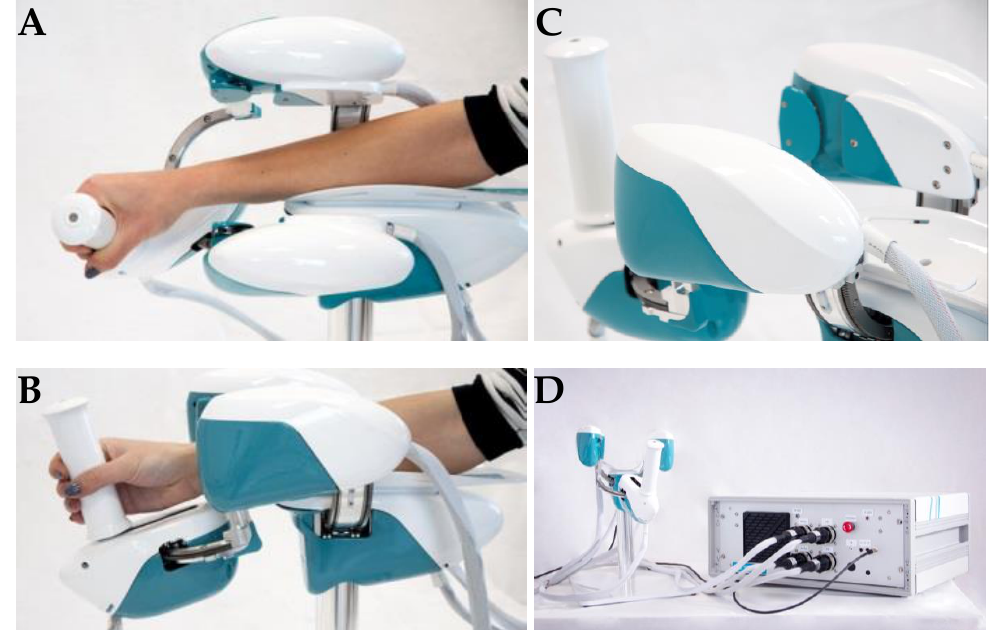
Figure 1. Lateral view of WristBot during combined movements in the flexion – extension and pronation – supination DOFs (degrees of freedom) ( A ) and movements in the radial – ulnar deviation DOF ( B ); posterior – lateral view of the handle of WristBot ( C ) and a frontal view of the device connected to the case, with the integrated PC and electronic control unit ( D ).